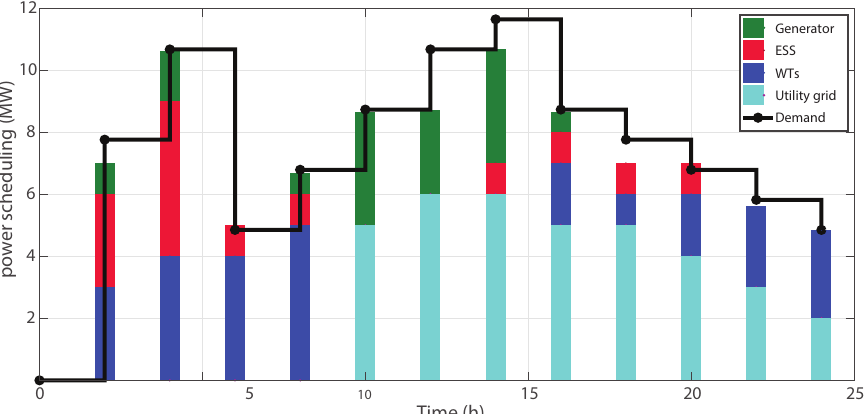
Figure 8. Power scheduling of distributed energy